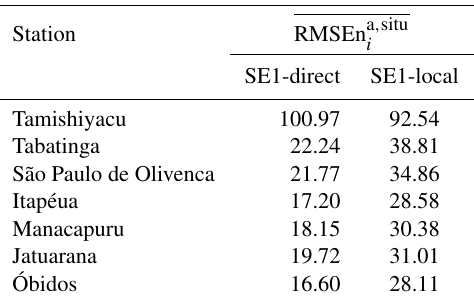
Table 5. Local RMSEn a , situ for the SE1-direct and SE1-local ex- i periments at in situ stations along the mainstream (from the most upstream to the most